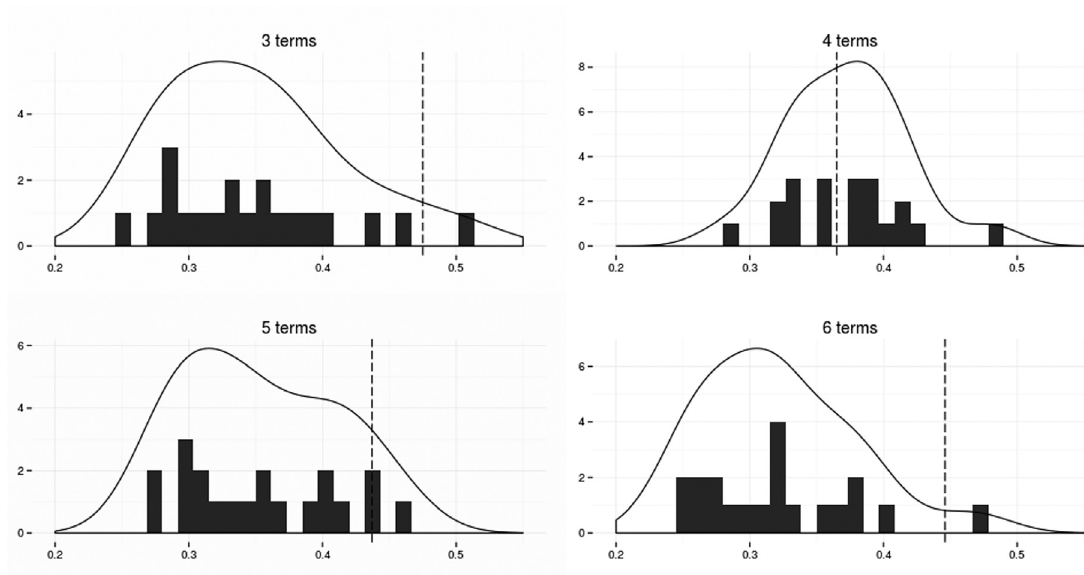
Figure 5: Histogram of maximal similarities of the resulting color-naming schemes of the first variant of the model: COM1. Solid line corresponds to a 1d kernel density estimate as produced with default parameters by the ‘ggplot2’ R package. Dashed line indicates the value obtained by